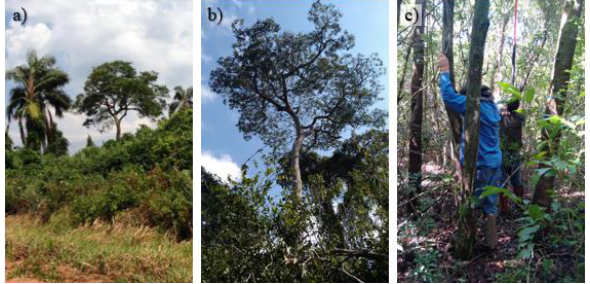
Figure 1. Images of the study area. a) Outside the area; b) c) Inside the area